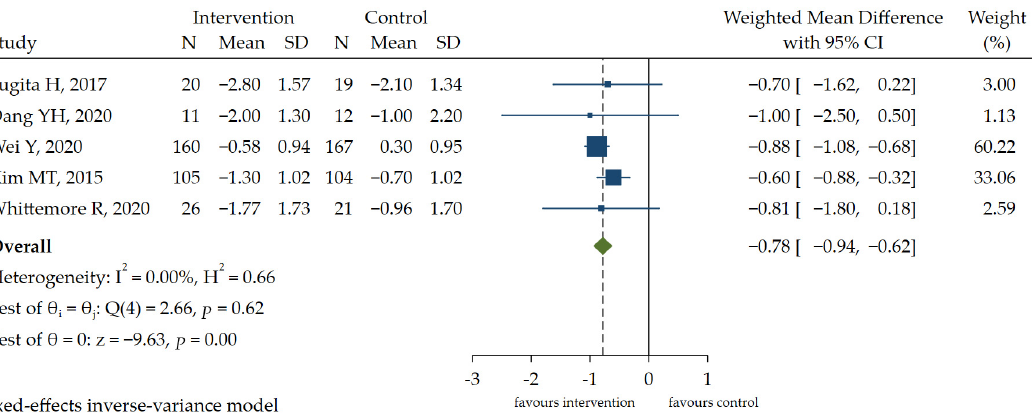
Figure 2. The forest plot of the effect of HL intervention on HbA1c [6,8,11,15,21].